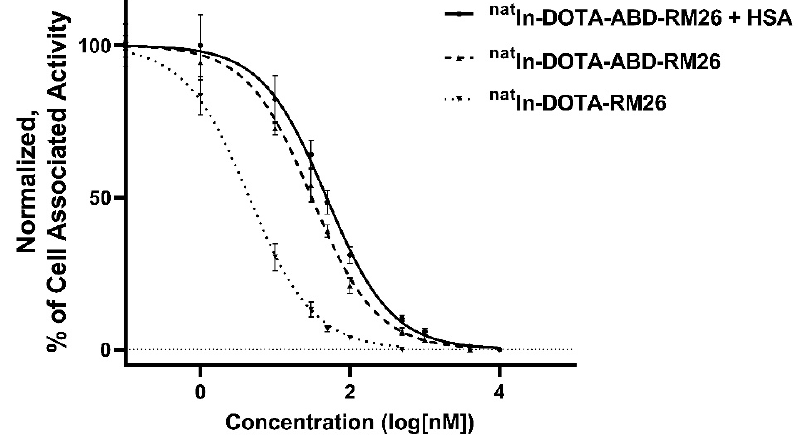
Figure 5. Half-maximal inhibitory concentration (IC 50 ). The error bars represent the standard deviation ( n = deviation ( n = 3).